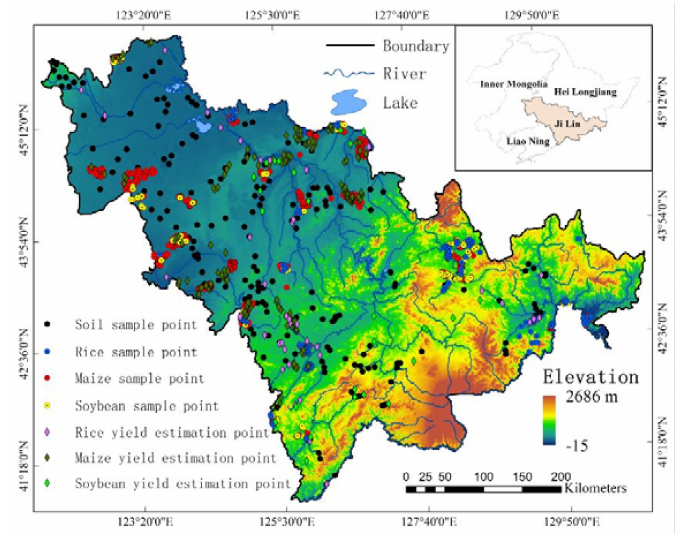
Figure 1. Location of the study area and sample